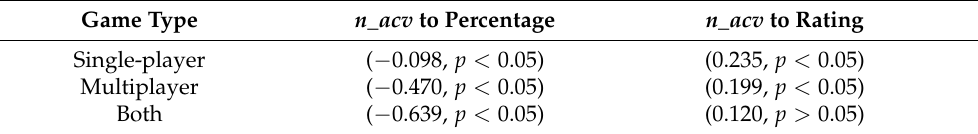
Table 7. Correlation between number and percentage of achievements and rating of Cluster 3.